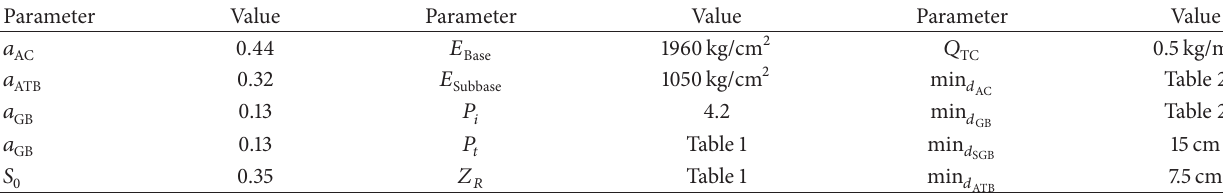
Table 4: Design parameters for developing design charts.